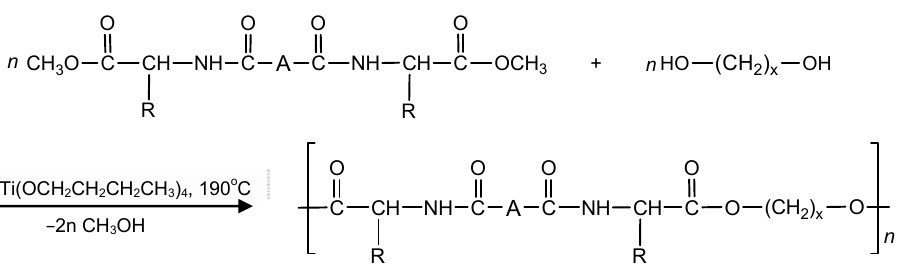
Figure 37. Synthesis of AABBP via thermal